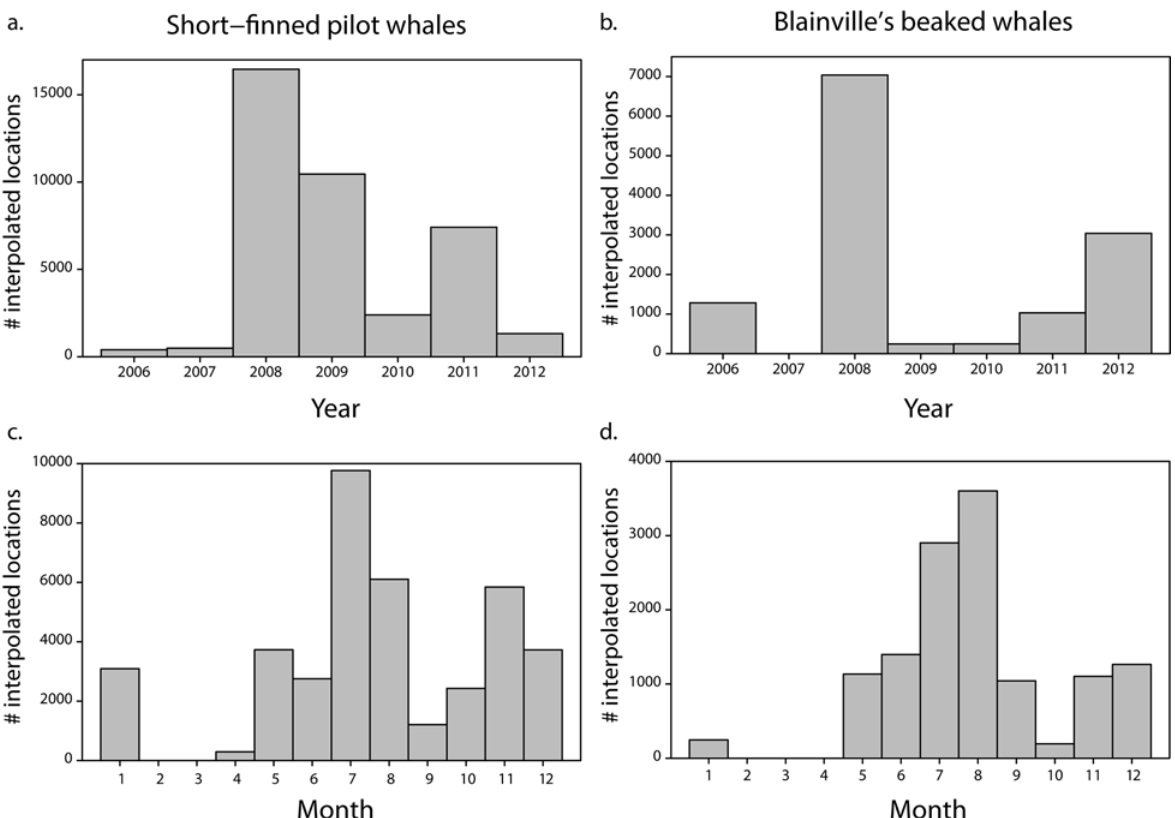
Fig 1. Distribution of whale data. Distribution of interpolated position estimates per year (a-b) or month (c-d) for short-finned pilot whales (a-c) and Blainville ’ s beaked whales (b-d).